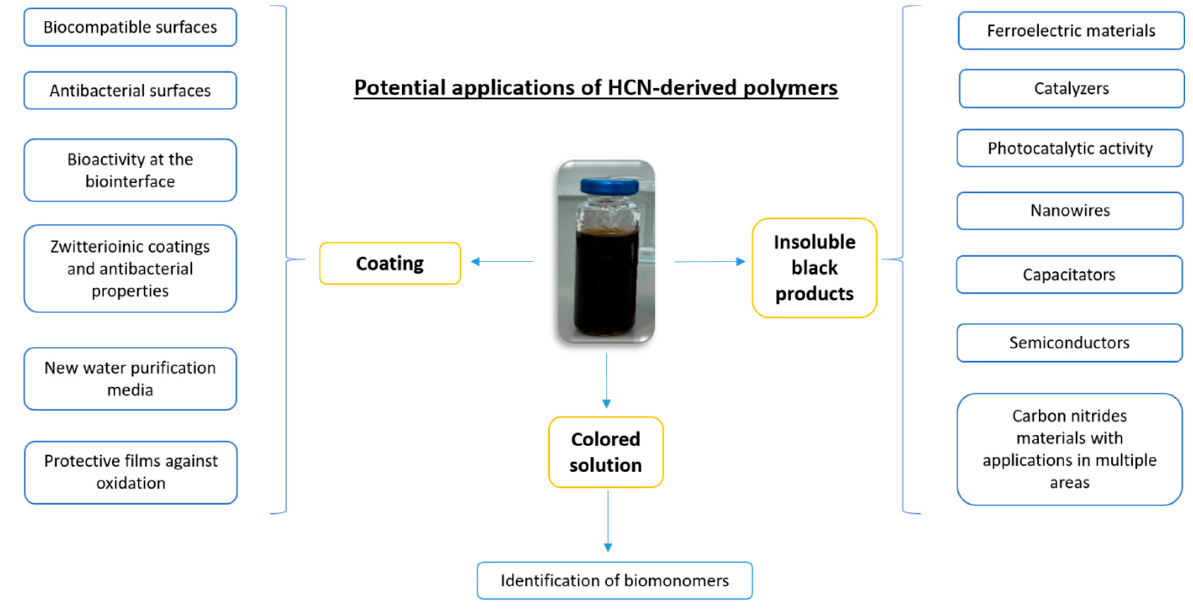
Figure 3. Current stage of the potential applications of HCN-derived polymers. The properties of HCN-derived polymers are directly dependent on the synthetic experimental conditions as well as on the chosen phase from the whole polymerization.